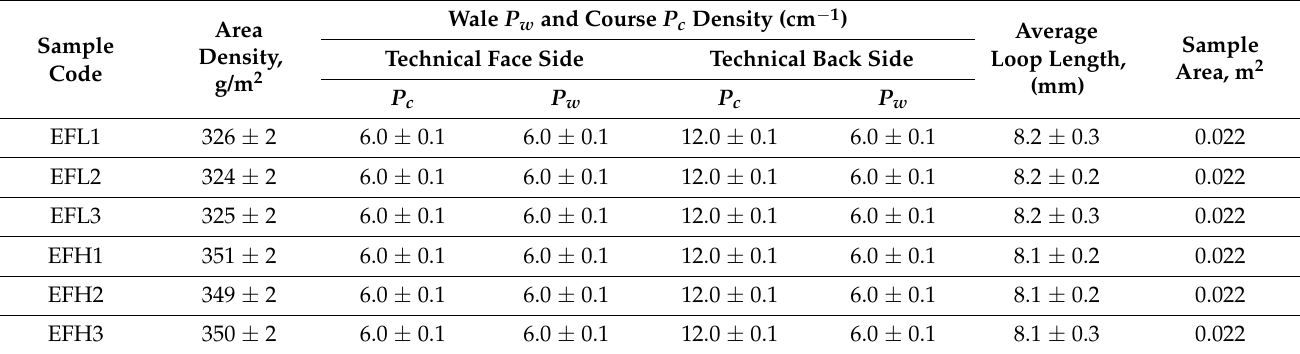
Table 2. Main characteristics of designed